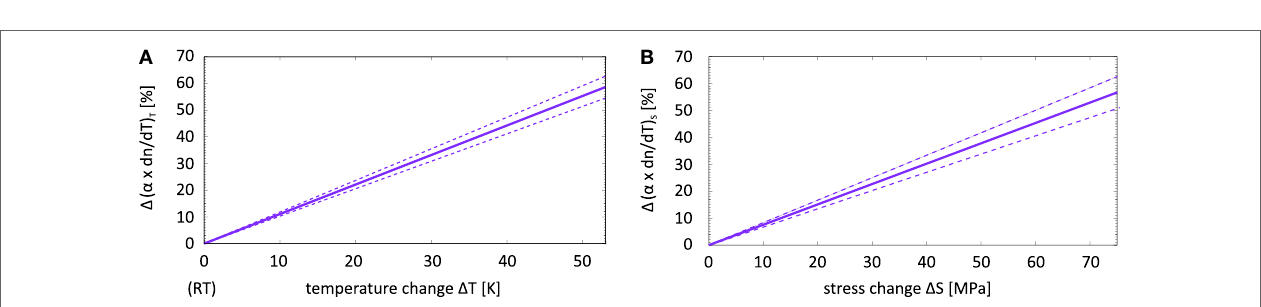
FIGURE 9 | Change in (cid:11) (cid:2) dn/dT of the membrane. (A) shows (cid:11) (cid:2) dn/dT as a function of the membrane temperature. (B) shows (cid:11) (cid:2) dn/dT as a function of stress where the stress is also a function of temperature. Green diamonds show the case for heating the frame with the 532 nm laser, and red crosses show the case for heating the membrane in the center with the 1,550-nm laser. Blue circles show the fitted (cid:11) (cid:2) dn/dT such as described in the text.